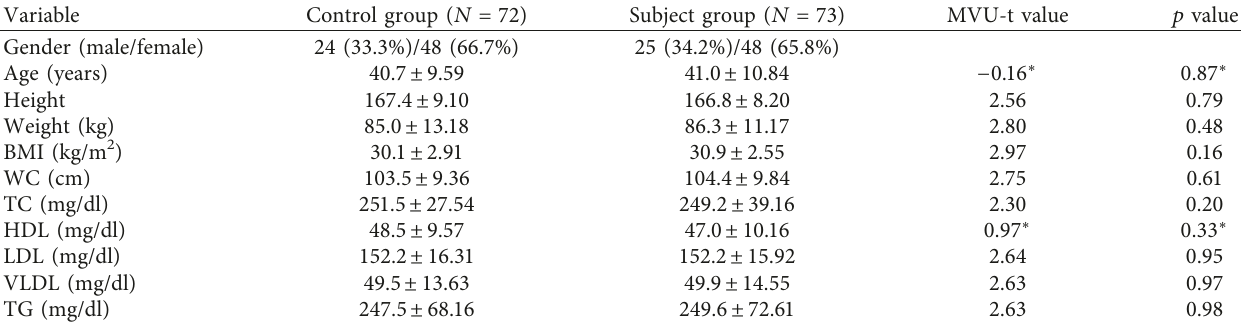
Table 1: Baseline values of demographic characteristics, anthropometric measurements, and blood lipid parameters between control and